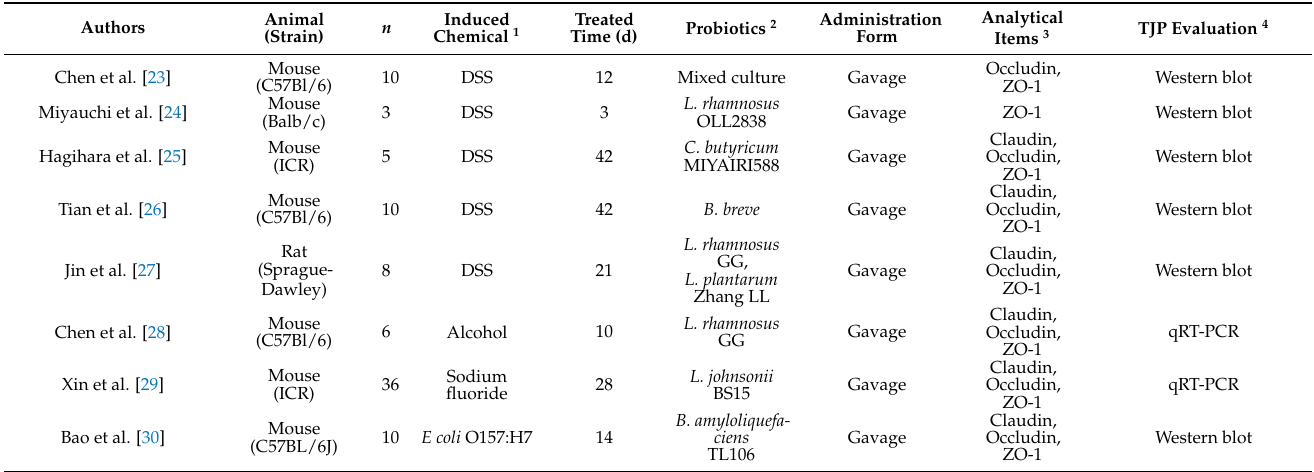
Table 1. Studies used in the data set and their information for the